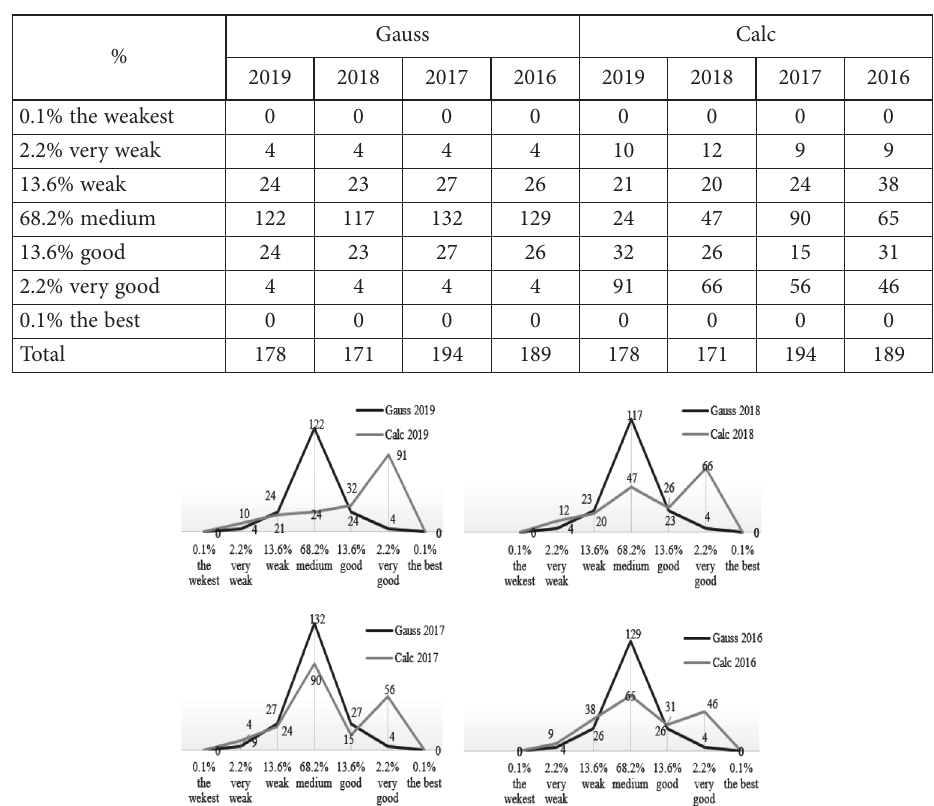
Figure 2. Graphical representation for Gauss and calculated values on